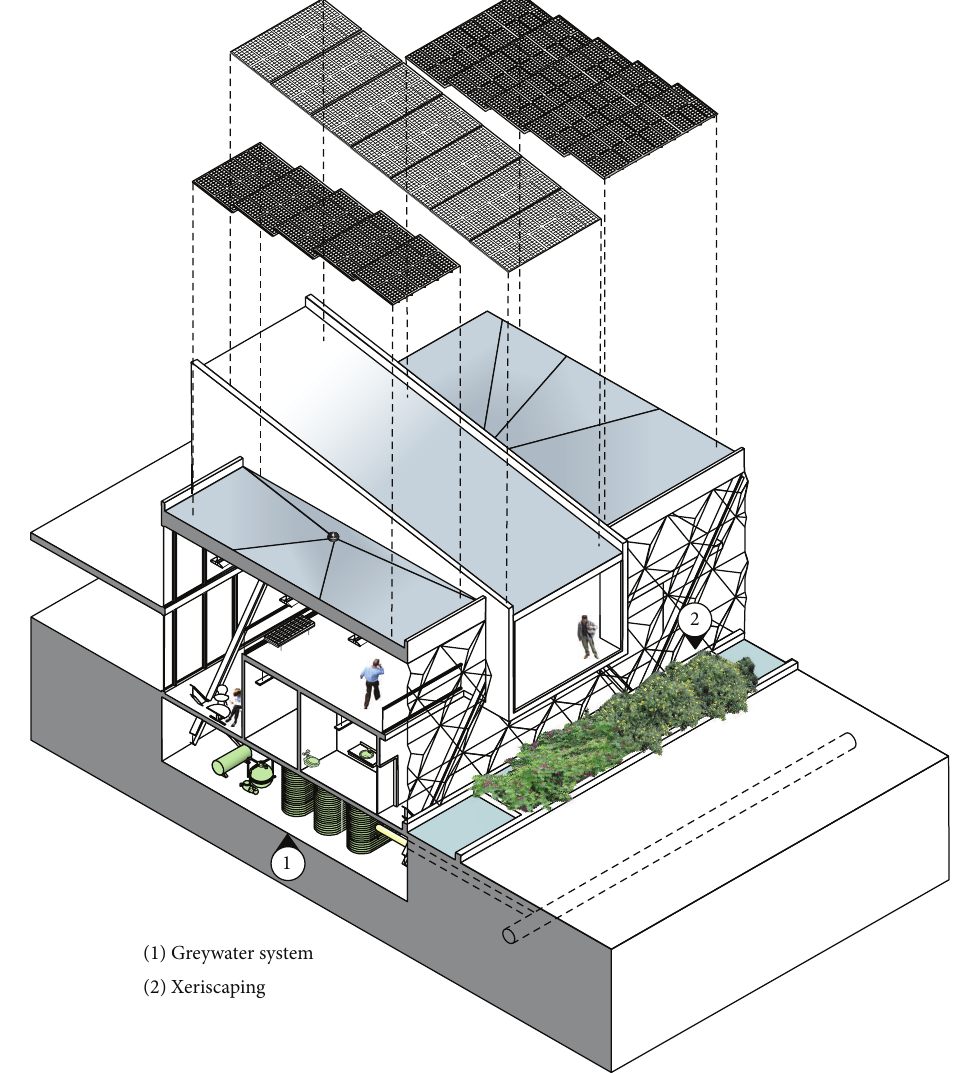
Figure 3: Water use reduction proposal for the